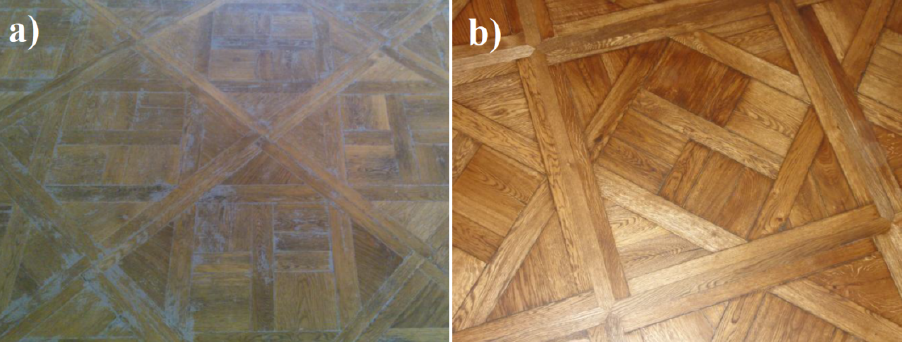
Figure 2: a) Palace floor before renovation; b) The final effect of the